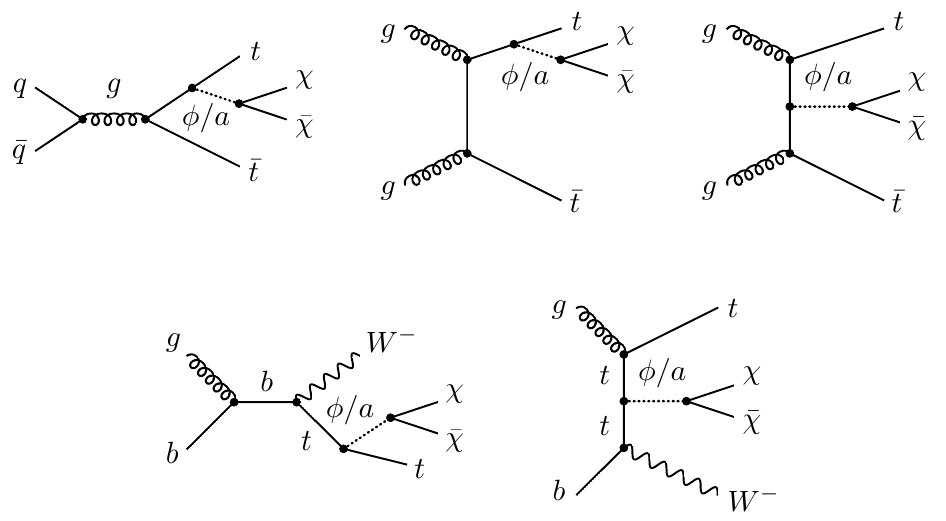
Figure 1 . Representative Feynman diagrams for t (cid:22) t + E miss production that involve the exchange of a scalar ( (cid:30) ) or pseudoscalar ( a ) mediator with the interac- tions speci(cid:12)ed in